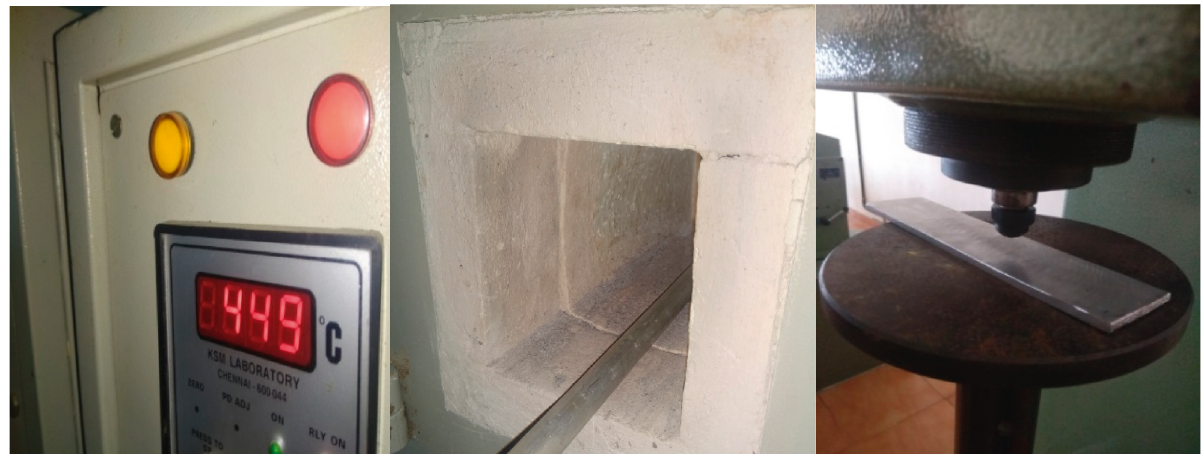
Figure 3: Heat treatment of specimen in a muffle furnace and hardness